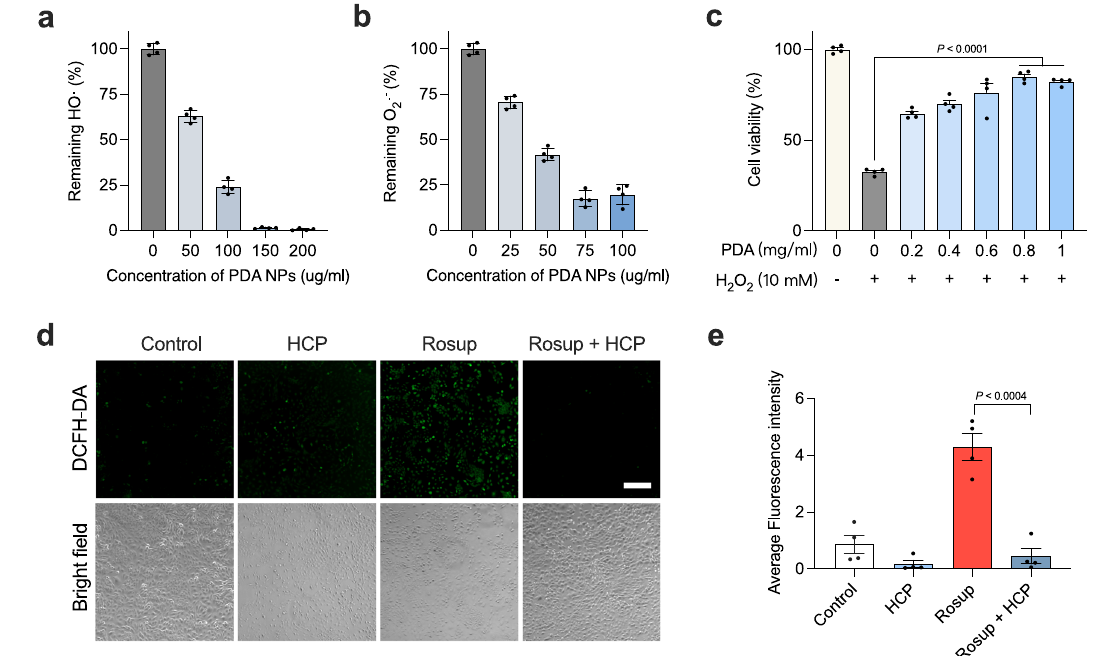
Fig. 4 | PDA NPs and HCP hydrogels can ef fi ciently scavenge ROS. a , b HO· and O 2 · − scavenging ef fi ciency of PDA NPs with different concentrations. n =4 samples and data are shown as mean±s.d. c Cytoprotective effect of HCP hydrogels with different concentrations of PDA NPs against 10mM H 2 O 2 . n =4 tests and data are shownasmean±s.e.m.andcomparedbyone-wayANOVAfollowedbyBonferroni ’ s post hoc test. d Intracellular ROS scavenging of HCP hydrogels. Cells seeded were